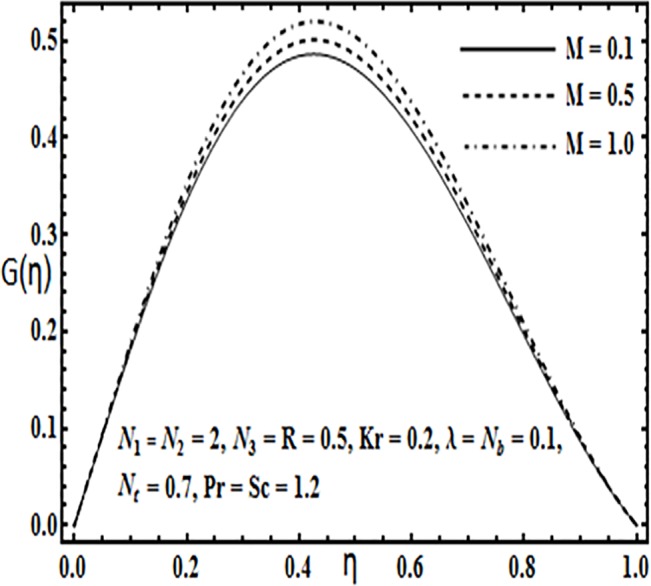
Effect of M on G(η).